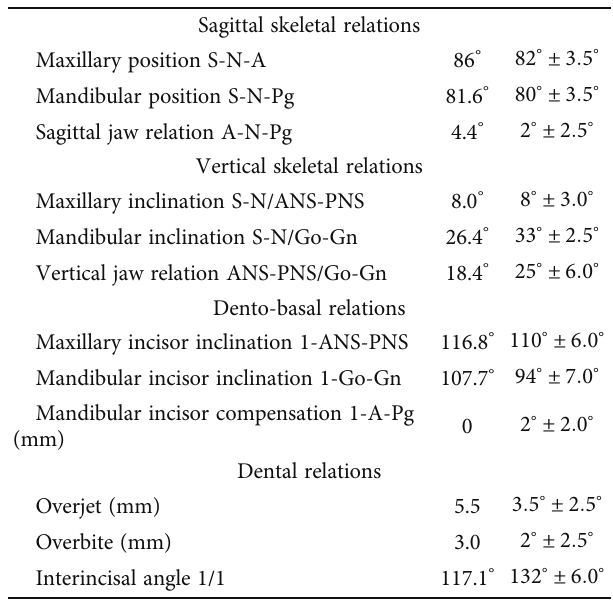
Table 4: Post-Herbst Pancherz cephalometrics values.